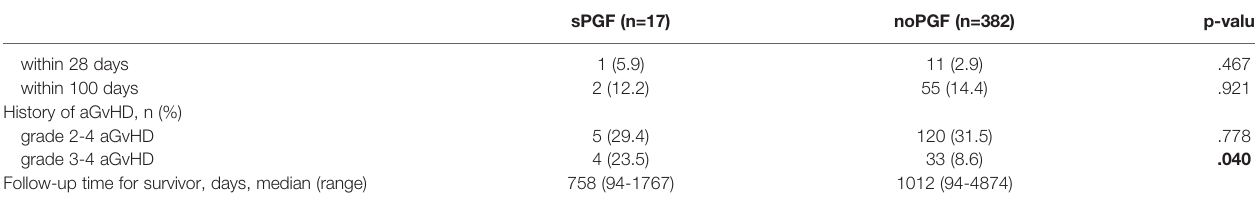
analysis ( Table 2 : model 1), later neutrophil engraftment and a